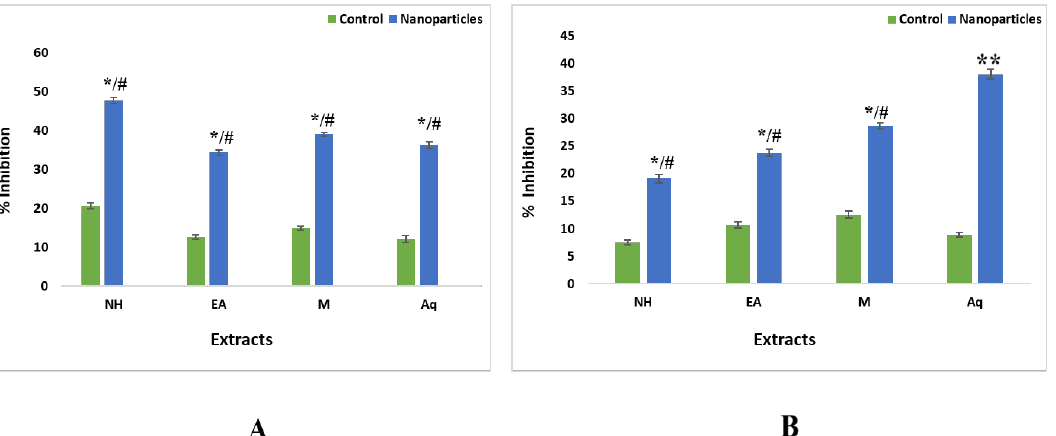
Figure 13. α -amylase inhibition potential of W. somnifera crude extracts and ZnONPs. ( A ) From Leaves ( B ) From Roots. Data are expressed as the mean ± SD. */# p < 0.05, ** p < 0.01.